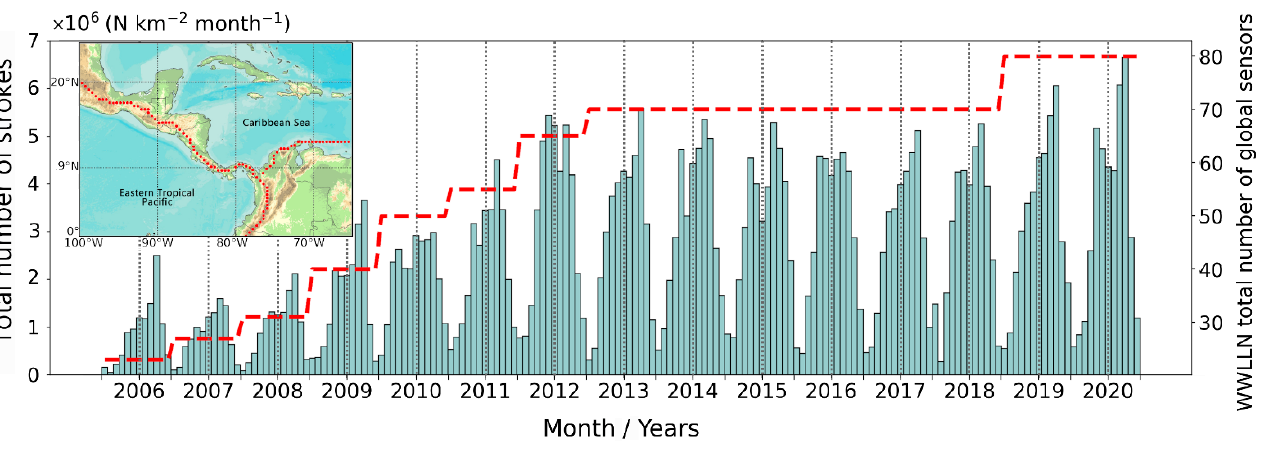
Figure 1. Total number N of strokes km −2 month −1 over the Extended Central America (ECA) region (inserted panel), and the total number of World Wide Lightning Location Network (WWLLN) sensors for each year of 2006–2020. The red broken line is the WWLLN global average number of sensors per year, approximately. The dotted red line separates, using the mountain peaks of ECA, the Caribbean, the eastern tropical Pacific basins from the northern part of South America.